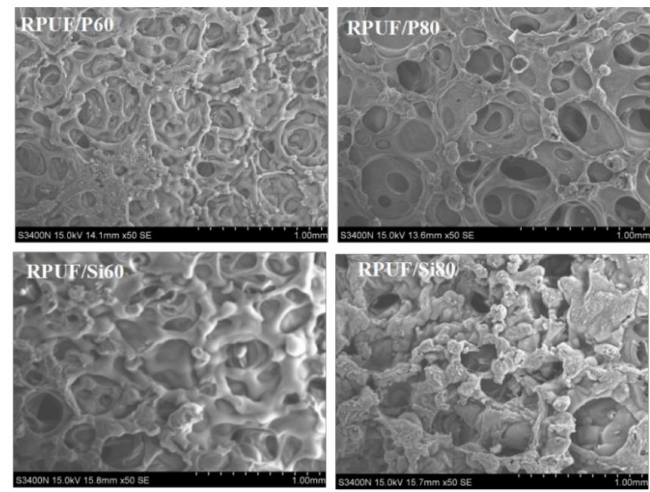
Figure 12. SEM of RPUF residue.